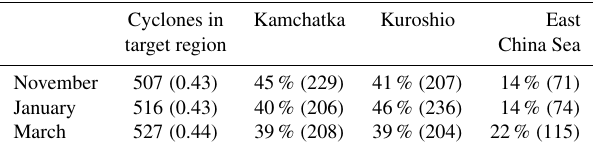
Table 1. Total number (first column) of surface cyclones in the northern target region and number of cyclones per day in paren- theses (1980–2018). Fraction and number (in parentheses) of (sec- ond column) Kamchatka, (third column) Kuroshio, and (fourth col- umn) East China Sea cyclones. The northern target region is shown in Fig. 1. For the genesis locations, the following definitions are used (see also Fig. 2). Kuroshio cyclones: south of 45 ◦ N and east